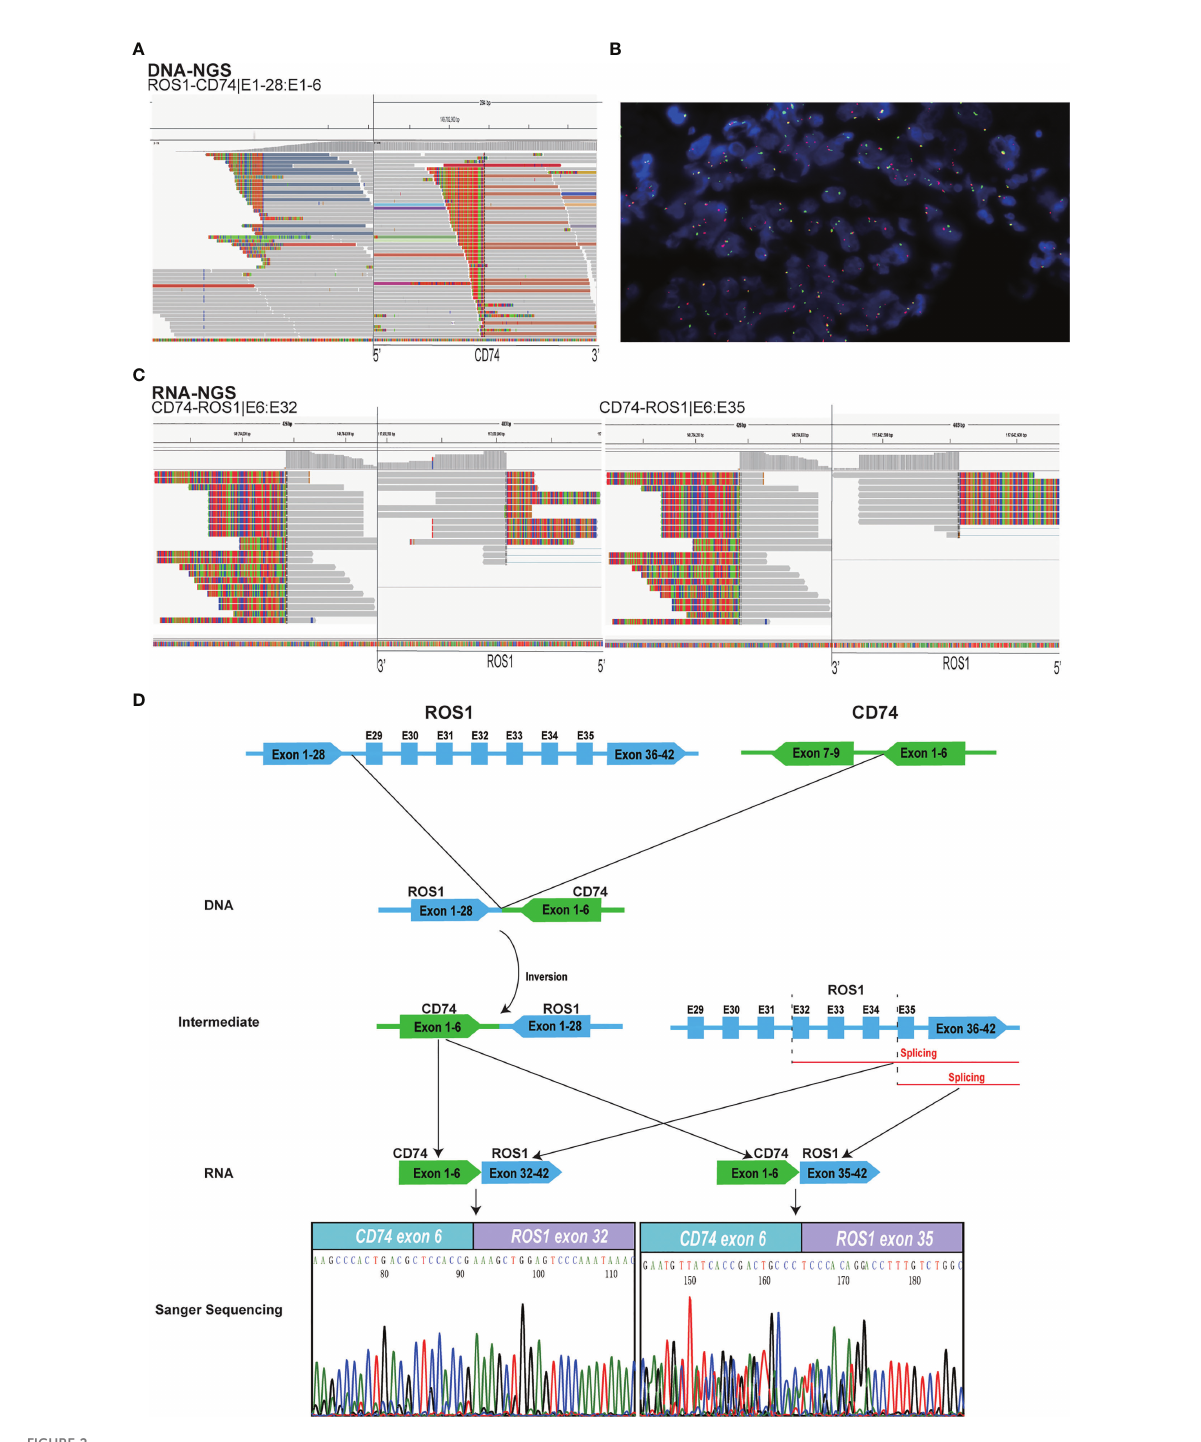
FIGURE 2 Identi fi cation of a novel ROS1 fusion. (A) DNA NGS analysis of the genomic ROS1-CD74 novel fusion. (B) FISH analysis showed fused yellow signals (negative signal), single green signals (positive signal), and single red signals (positive signal) in the patient ’ s specimen. (C) RNA NGS analysis of the dual CD74-ROS1 fusions at transcript level. (D) Possible schematic diagram of ROS1-CD74 fusion detected by DNA-based NGS, but CD74-ROS1 fusions were identi fi ed by RNA-based NGS. NGS, next-generation sequencing; TKI, tyrosine kinase inhibitor; FISH, fl uorescence in situ